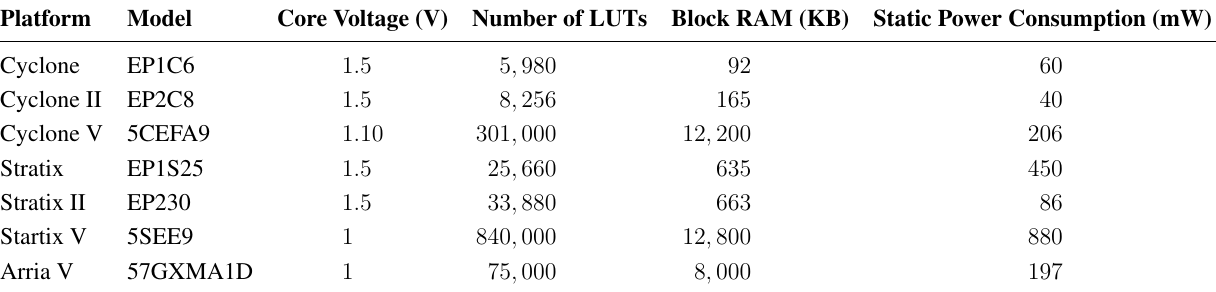
Table 2. Power consumption and operating voltage of Altera FPGAs.